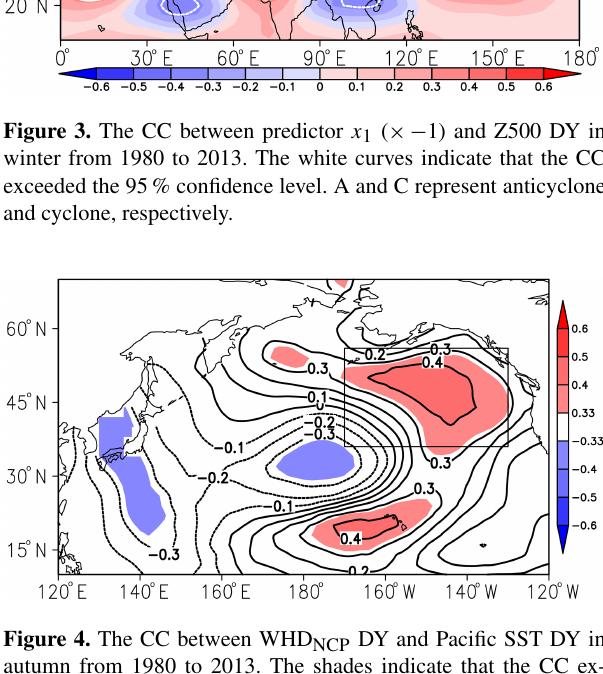
Figure 4. The CC between WHD NCP DY and Pacific SST DY in autumn from 1980 to 2013. The shades indicate that the CC ex- ceeded the 95% confidence level, and the rectangle represents the selected region (36–56 ◦ N, 130–170 ◦ W) of predictor x 2 .